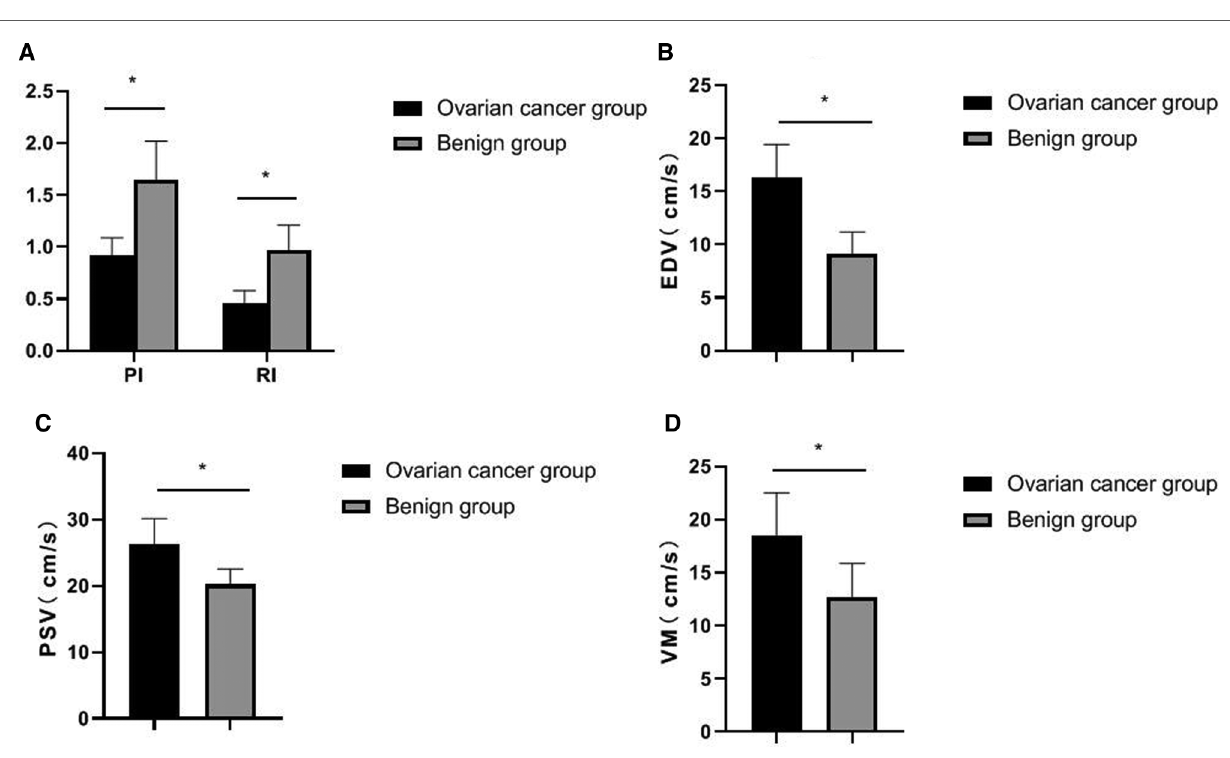
FIGURE 2 | Comparison of two-dimensional ultrasound results between the two groups. ( A ) PI and RI; ( B ) EDV; ( C ) PSV; ( D )